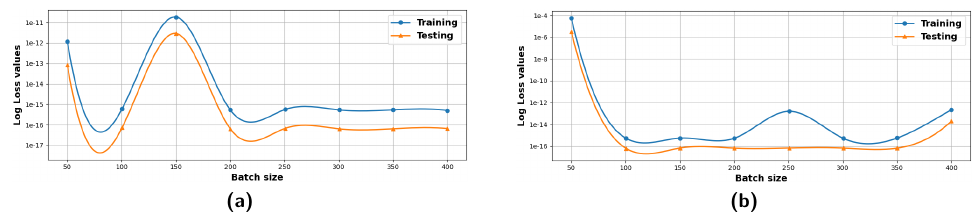
Figure 11: Log loss values for different batch sizes. The weights and biases are initialized based on (a) He, and (b) Xavier initialization techniques. The results are shown for a randomly chosen class.